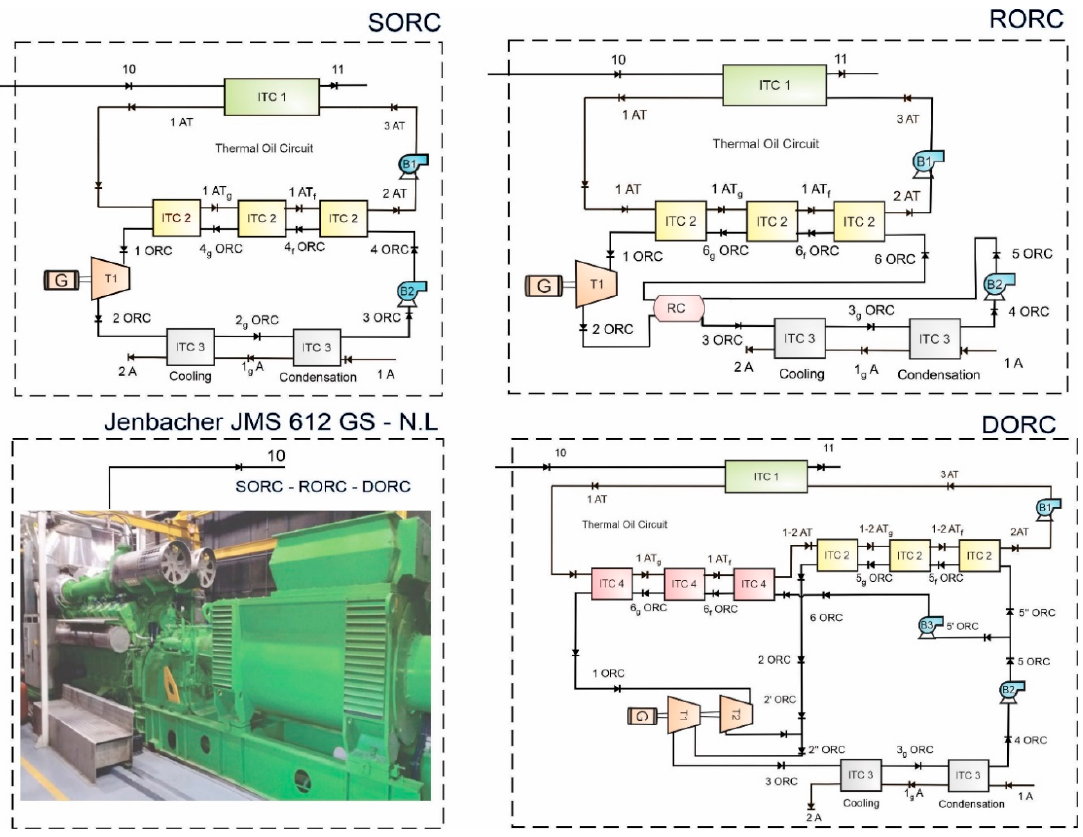
Figure 2. Physical structure of the simple ORC (SORC), ORC with recuperator (RORC), and double- pressure ORC (DORC) configurations.